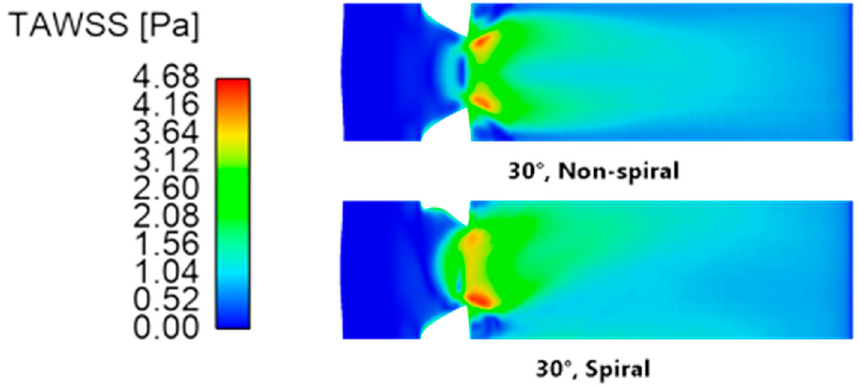
Figure 14. Time-averaged wall shear stress contours of the artery (unrolled) using a 30° anastomosis angle with non-spiral and spiral graft configurations.